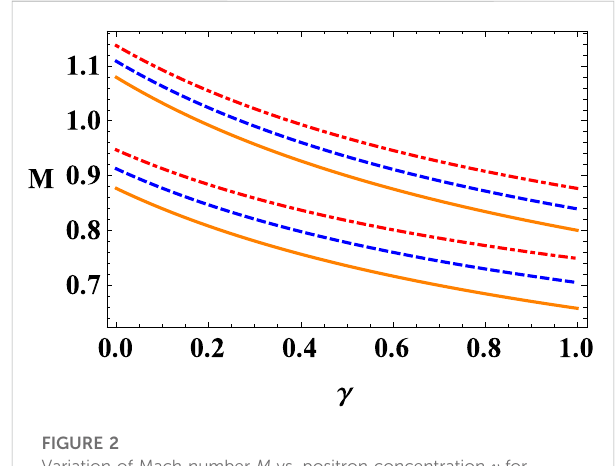
FIGURE 2 Variation of Mach number M vs. positron concentration γ for differentvaluesof p (cid:3) =0.20(solidcurve),0.30(dashedcurve)and0.40 (dot-dashed curve) with α = 0.80, p ⊥ = 0.1 and σ =